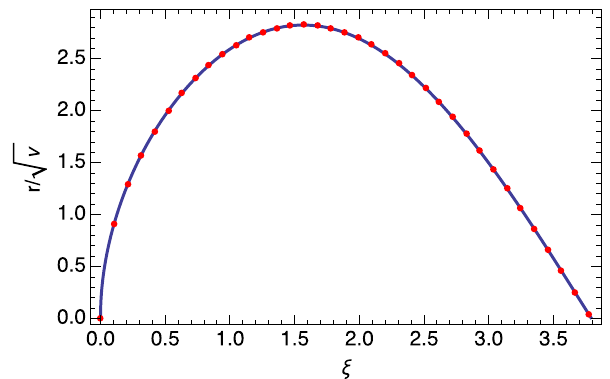
FIG. 5. Comparison of the analytical expression for the bubble boundary (25) and (28) (red dots) with the numerical solution (solid